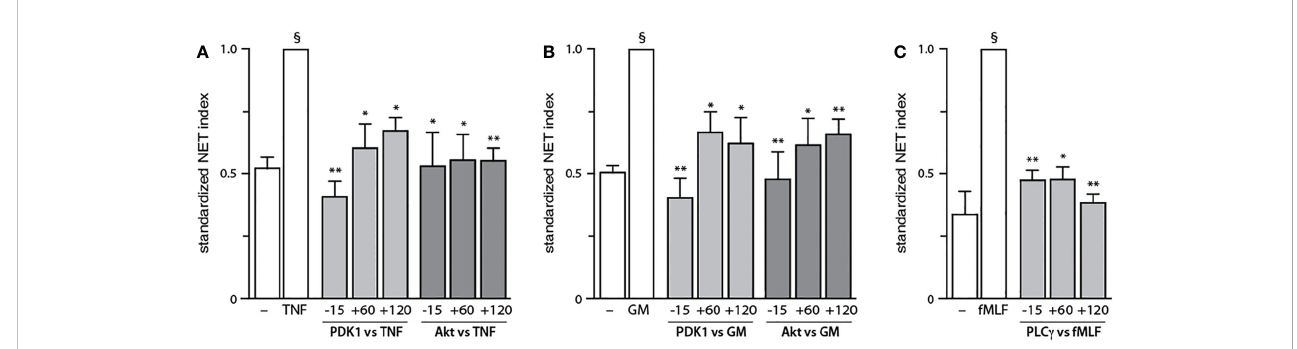
FIGURE 6 Belated contribution of PDK1, Akt, and PLC g to NET generation. Neutrophils cultured at 37°C on poly-L-lysine-coated coverslips were treated either before (-15 min) or after (+60 or +120 min) stimulation with the following inhibitors or their diluent (0.1% DMSO): 5 m M BX-912 (PDK1 inhibitor); 10 m M Akt inhibitor VIII (Akt inhibitor); or 1 m M U73122 (PLC g inhibitor). The cells were stimulated or not for 4 h at 37°C with (A) 100 U/ml TNF a , (B) 1 nM GM- CSF, or (C) 100 nM fMLF. NET formation was assessed using PlaNET Green as described in Methods . Mean ± s.e.m. from at least 3 independent experiments. *, p<0.05; **, p<0.01 vs stimulus alone. §, p < 0.003 for unstimulated cells vs